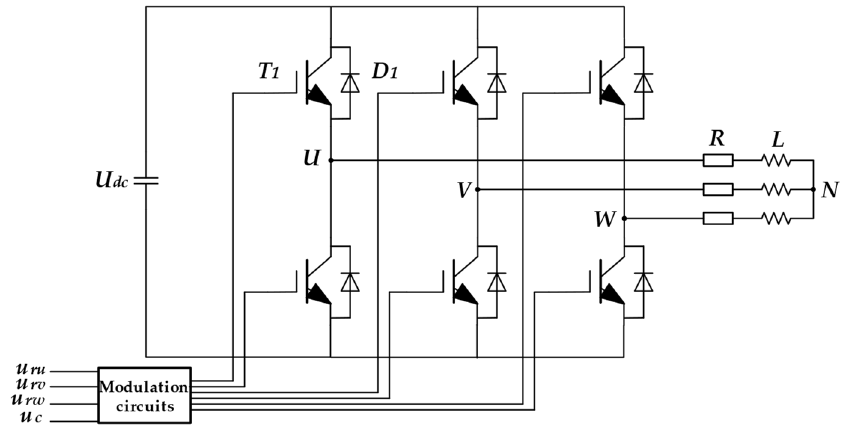
Figure 2. Three-phase inverter circuit.